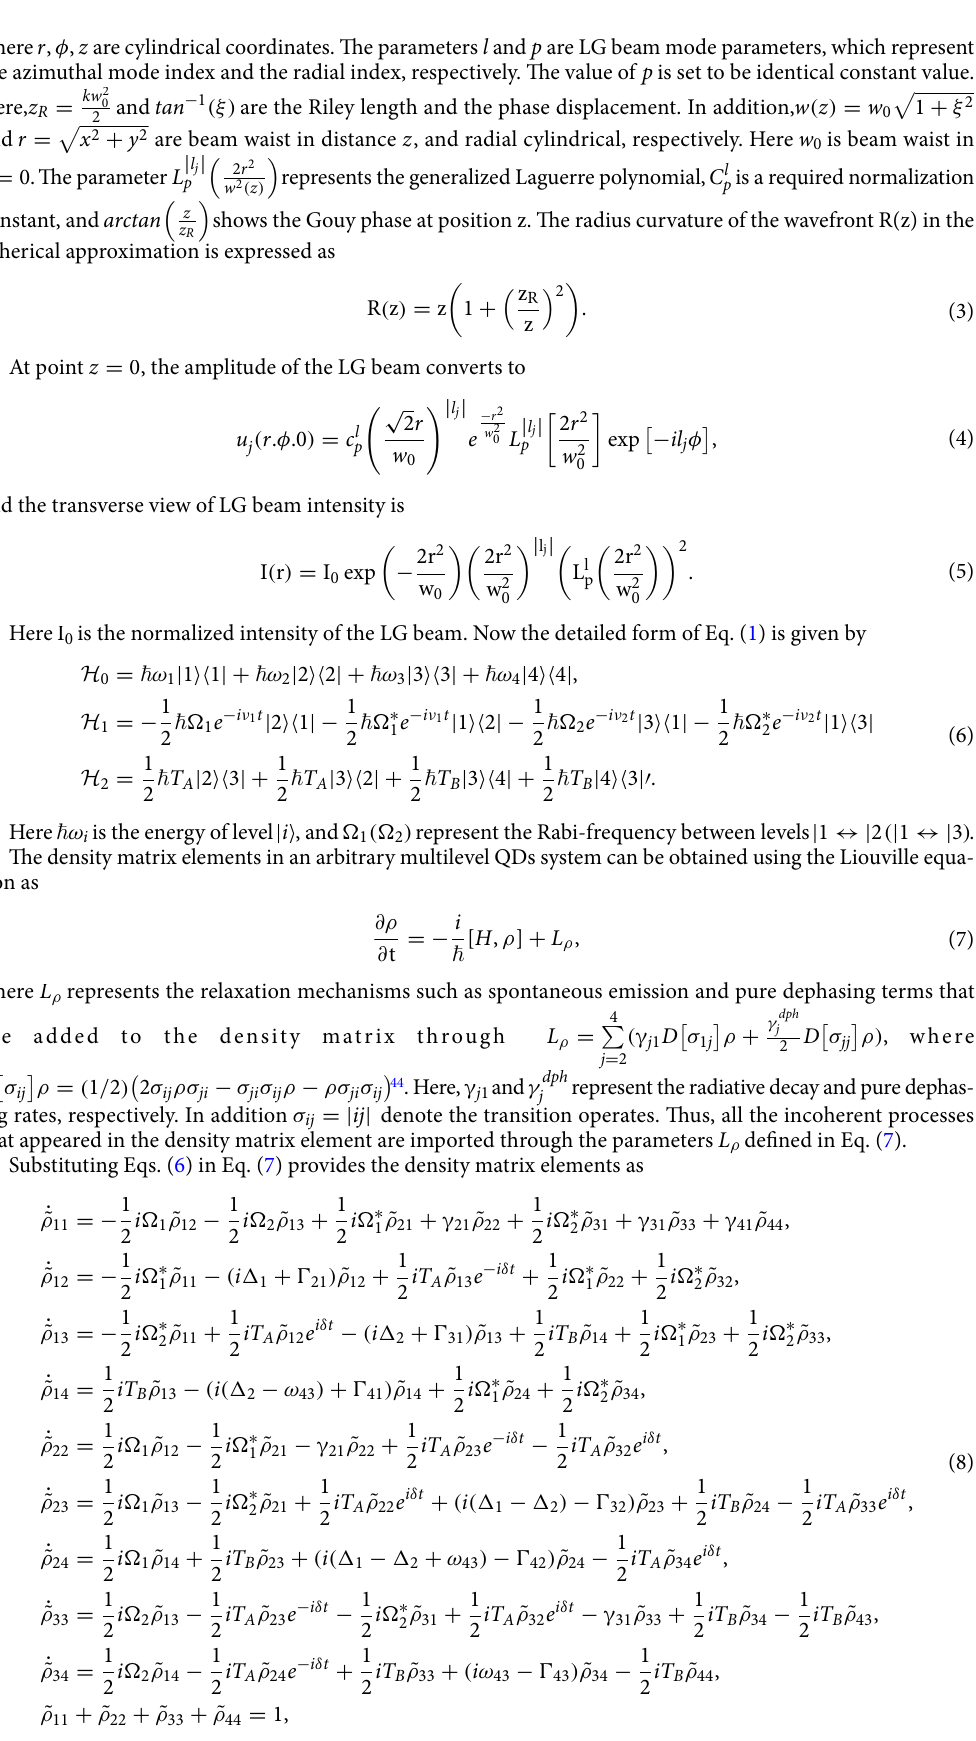
where r , φ , z are cylindrical coordinates. The parameters l and p are LG beam mode parameters, which represent the azimuthal mode index and the radial index, respectively. The value of p is set to be identical constant value. kw 2 0 tan − 1 (ξ) are the Riley length and the phase displacement. In addition, w ( z ) Here, z R 2 and = x 2 y 2 are beam waist in distance z , and radial cylindrical, respectively. Here w 0 is beam waist in and r = + l j z 0. The parameter L | | p represents the generalized Laguerre polynomial, C l p is a required normalization = constant, and arctan shows the Gouy phase at position z. The radius curvature of the wavefront R(z) in the spherical approximation is expressed as